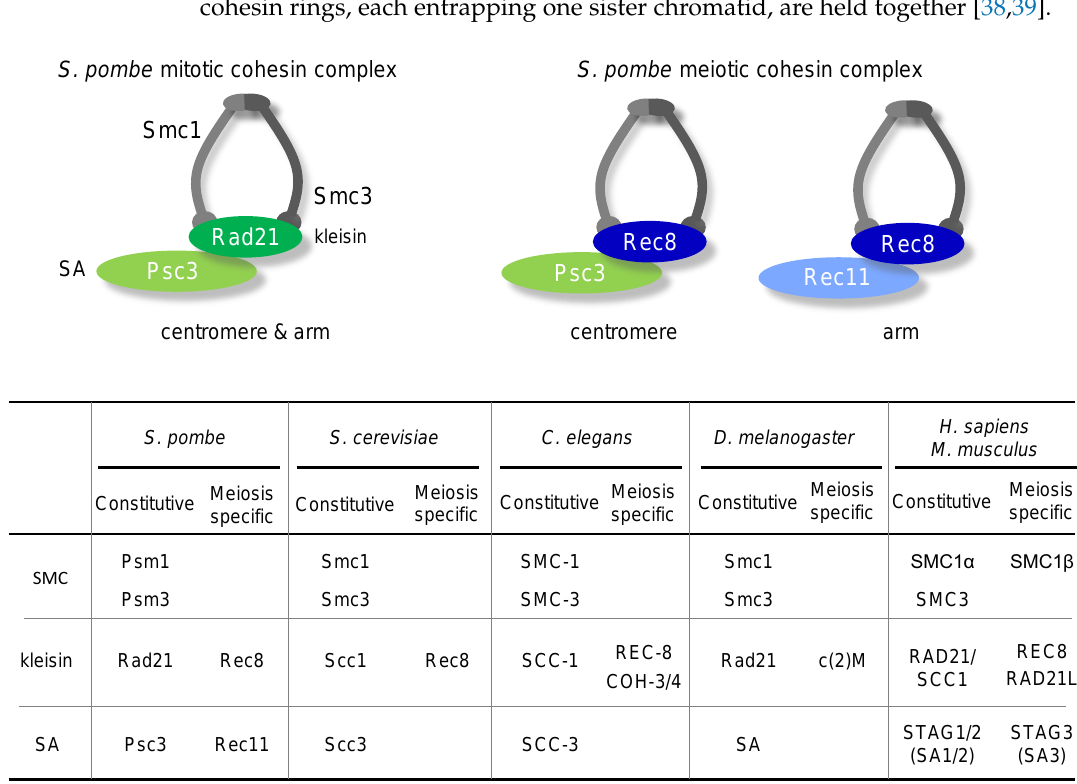
Figure 3. Cohesin complex in mitosis and meiosis. ( A ). A schematic diagram of cohesin complexes in Schizosaccharomyces pombe . During mitosis in S. pombe , the Rad21-Psc3 cohesin complex is distributed at the centromere and along the chromosome arm. During meiosis, the Rec8-Psc3 cohesin complex is localized only at the centromere, whereas the Rec8-Rec11 cohesin complex is distributed along the chromosome arms. ( B ). Nomenclature for the subunits of the cohesin complex in representative eukaryotic model organisms. The constitutively expressed subunits and the meiosis-specific subunits are